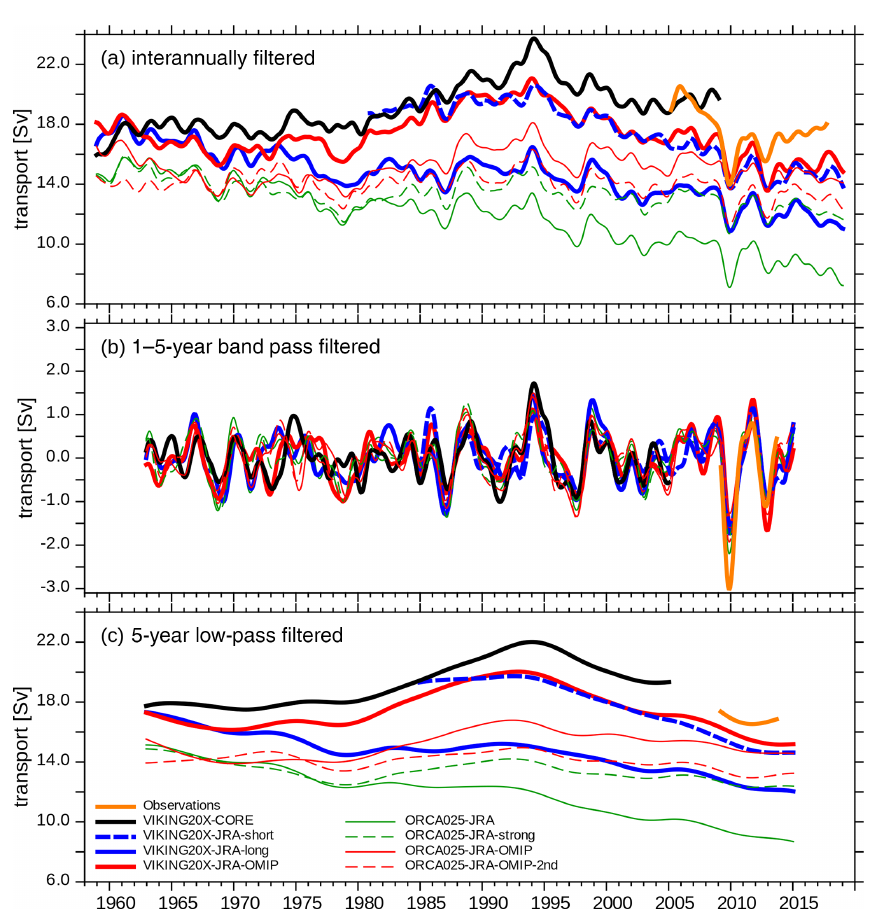
Figure 5. AMOC evolution, provided by the strength of the NADW cell at 26.5 ◦ N: (a) full interannual, (b) 1–5-year band pass and (c) 5-year low-pass filtered time